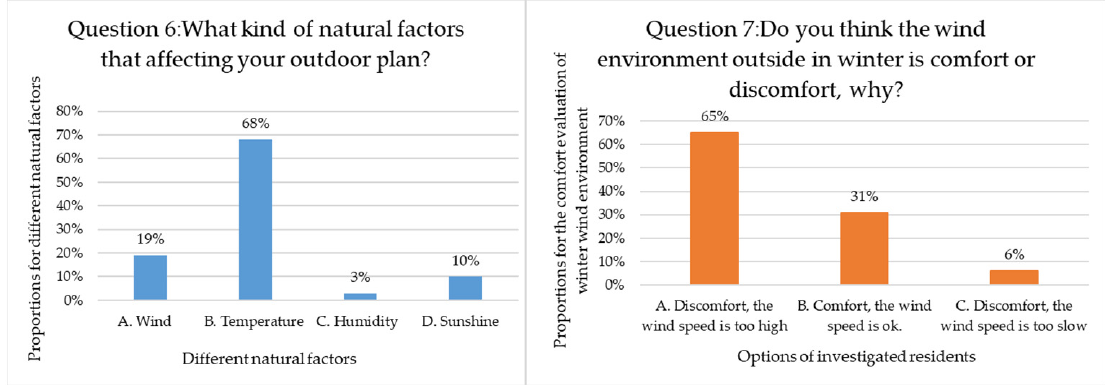
Figure 9. The survey results for Questions 6 and 7 of the questionnaires.